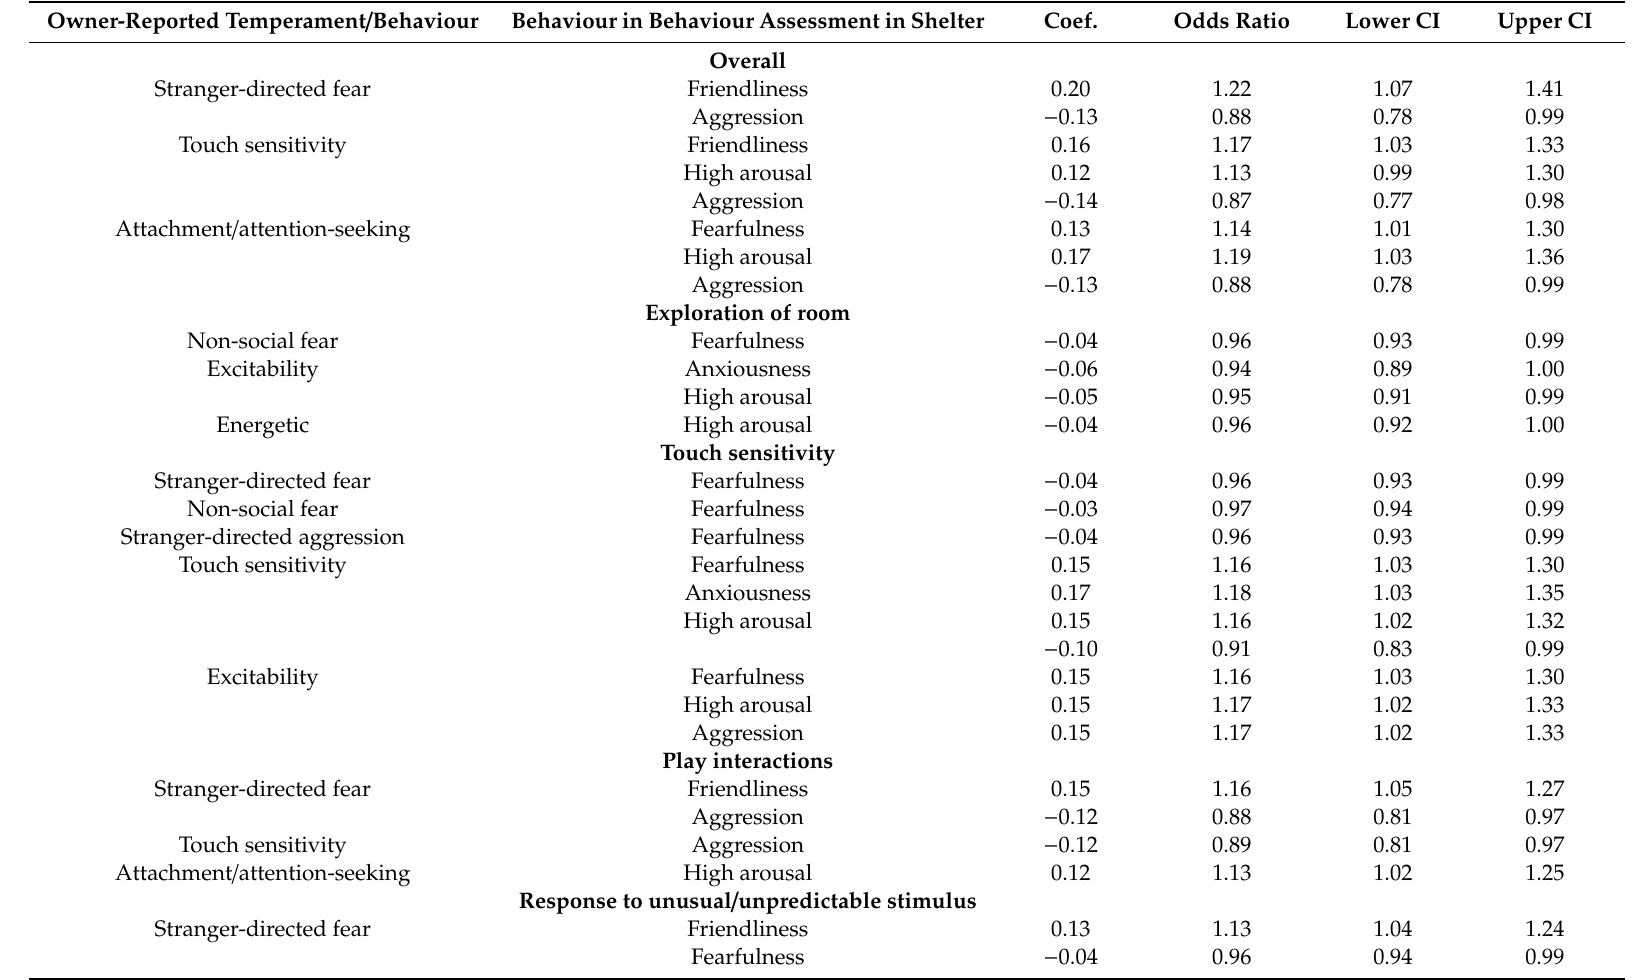
Table 4. Significant ( p < 0.01) relationships between the owner-reported temperament / behaviour and the behaviours derived from the overall behaviour assessment and individual tests, conducted in the shelter, determined by ordinal logistic